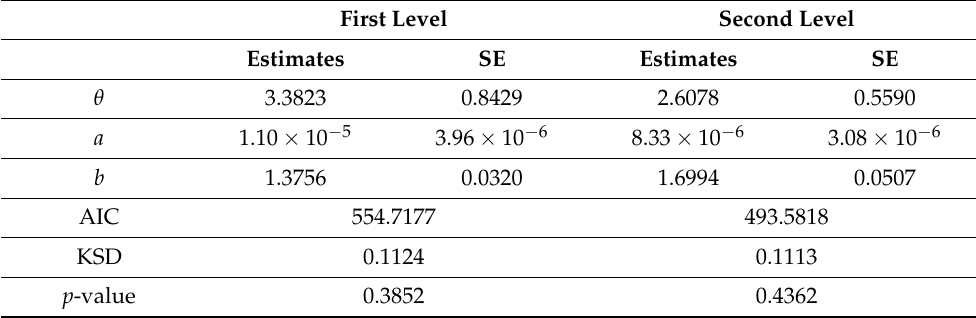
Table 7. MLE and Kolmogorov–Smirnov test for each stress level of real data.